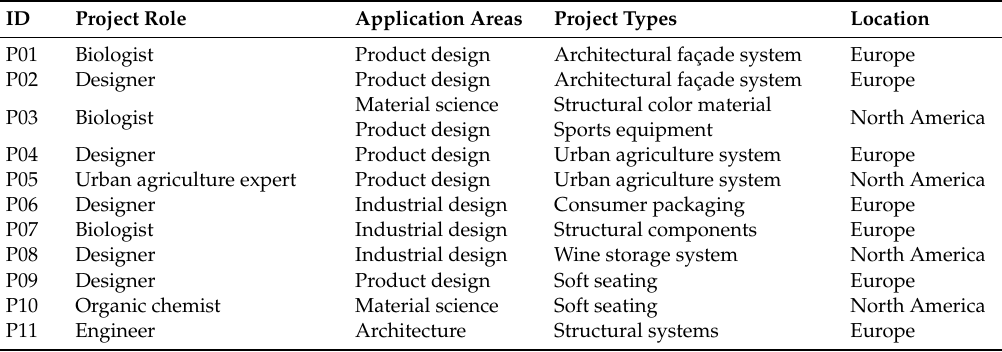
Table 1. Summary of semi-structured interview